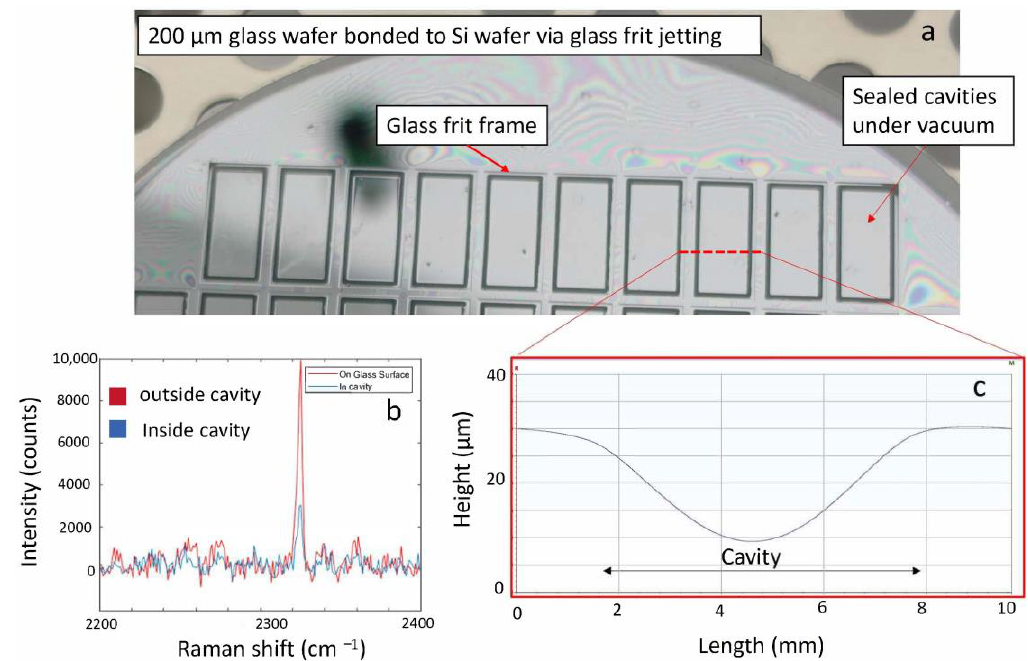
Figure 9. Glass frit wafer bonding results of the cap wafer bonded to a 200 µm thick glass wafer ( a ) optical image of the wafer implying the sealed cavities under low vacuum (10 Pa). ( b ) the Raman spectroscopy result indicating the hermeticity of the cavities in terms of N2 level. ( c ) shows the deflection of the thin glass wafer in the cavity area due to the pressure difference manifesting the hermeticity of the cavities.